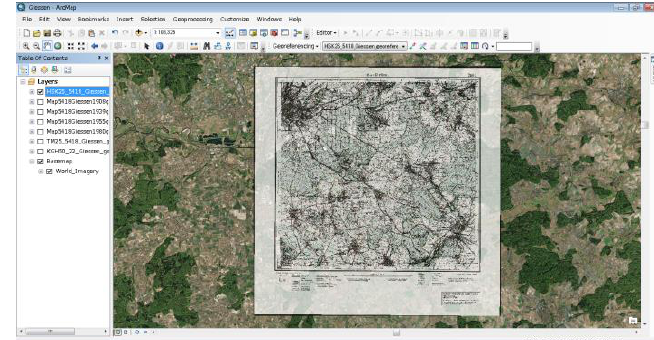
Figure 21. Map of Giessen: